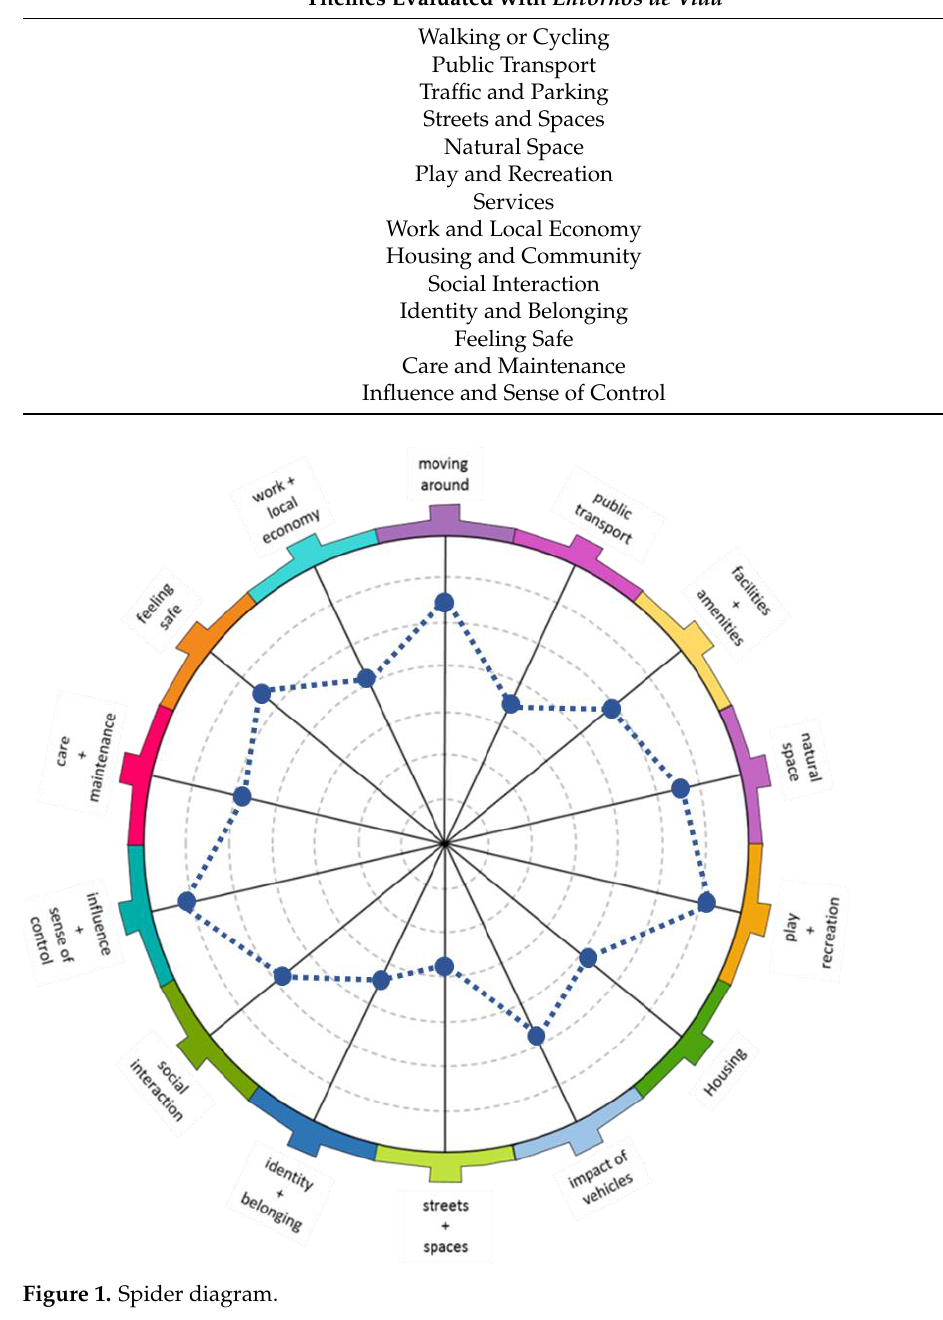
Figure 1. Spider